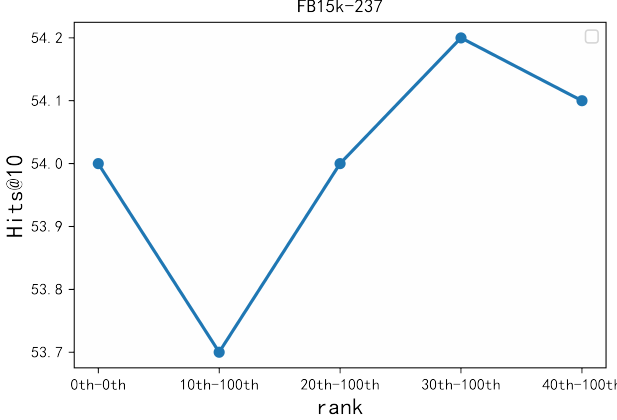
Figure 4. Experimental results on FB15k-237, evaluated in terms of Hits@10 for rank ( r s - r t ) ∈ { 0th- 0th, 10th–100th, 20th–100th, 30th–100th, 40th–100th } .